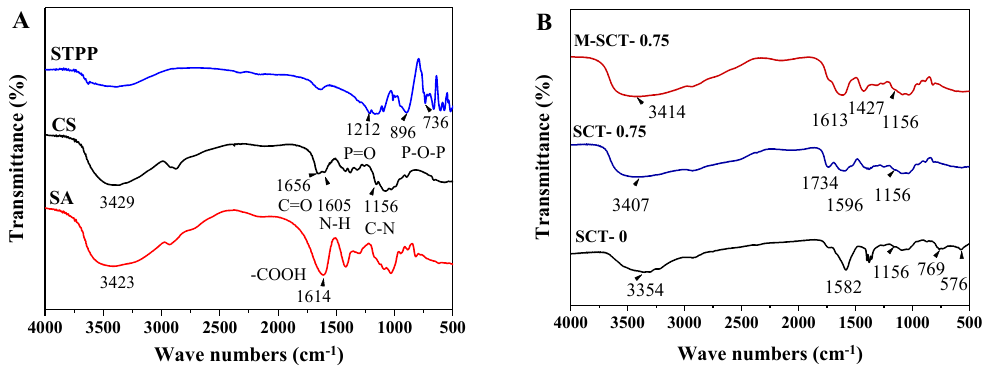
Figure 5. CS, SA, and STPP are cross-linked by electrostatic interaction. Chemical structure analysis of pure materials using FTIR spectroscopy ( A ). Analysis of intermolecular interaction forces between composite hydrogels using FTIR spectroscopy ( B ).